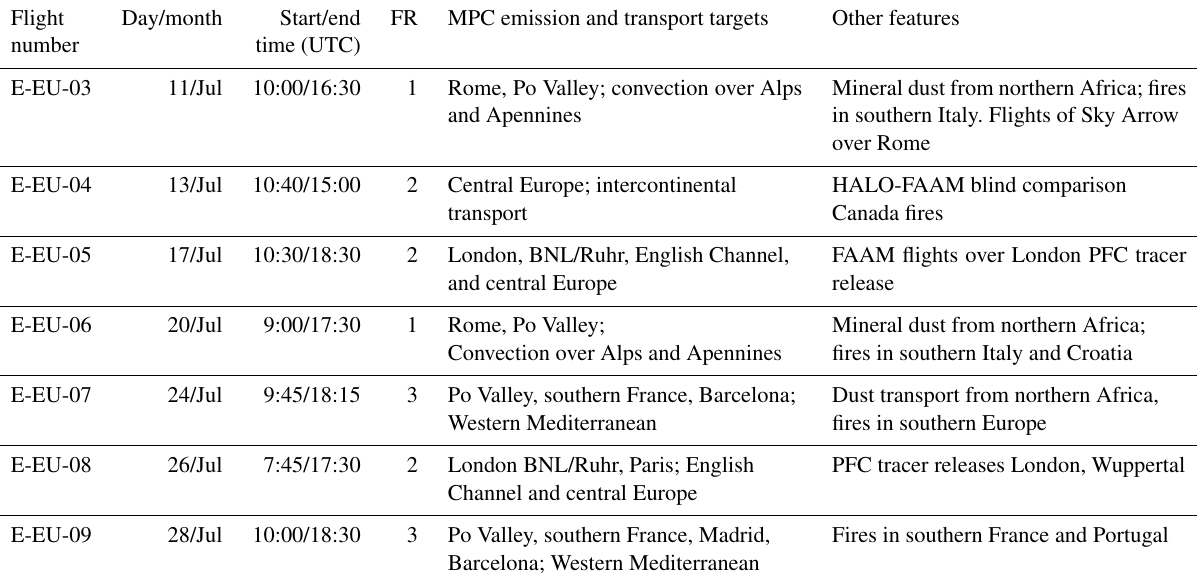
Table 3. Characteristics of the HALO flights carried out in Europe during EMeRGe. FR: flight region. Note that E-EU-01 and E-EU-02 were technical flights and are not considered in the present